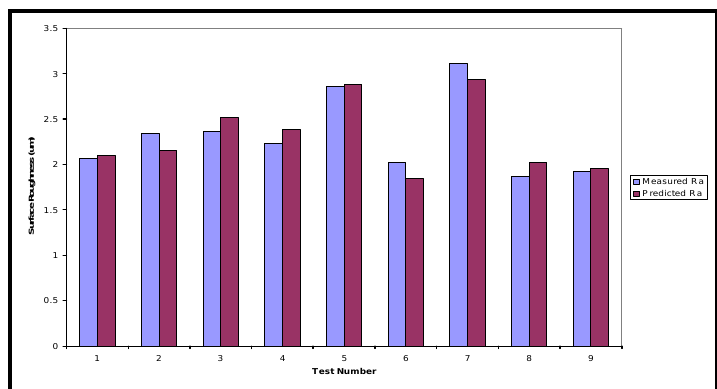
Fig. 3. The diagram of the measured and predicted surface roughness for the experimental data.